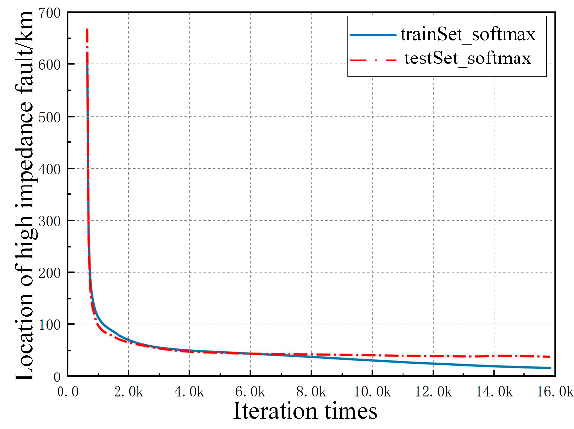
Figure 10. Regression prediction for fault location.